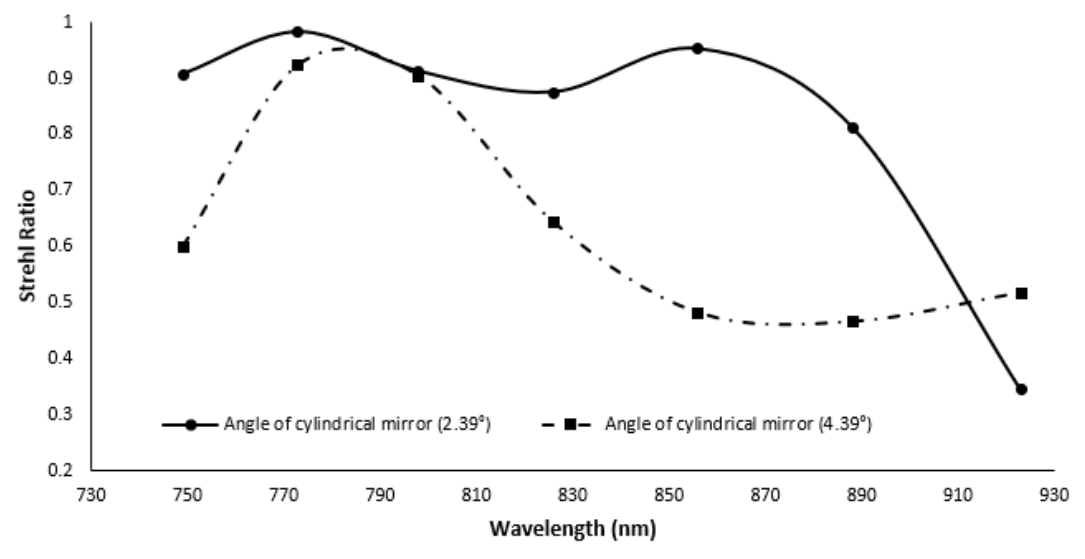
Figure 8. Strehl ratio of the proposed spectrometer for variation of the cylindrical mirror’s